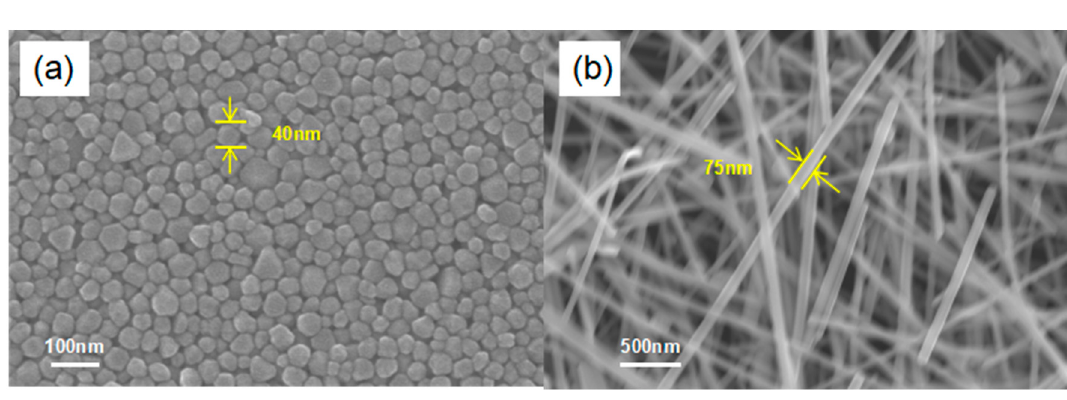
Figure 1. The morphology of synthesized silver: ( a ) nanoparticles; and ( b ) nanowires.